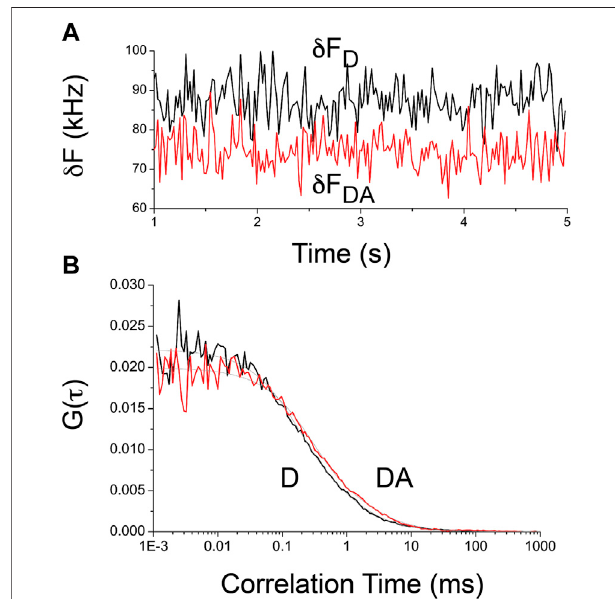
FIGURE 2 | Representative time-dependent fl uorescence fl uctuations and autocorrelation curves of intact and enzymatically-cleaved crTC2.1 construct (A) Representative fl uorescence fl uctuation traces of cleaved (black trace) and intact (red trace) of crTC2.1 indicate difference in the average number of fl uorescence photons detected during their translational diffusion through the open observation volume (B) The corresponding autocorrelation curves of cleaved (black curve) and intact (red curve) of crTC2.1. Under 405 nm excitation (7 μ W), the fi tting parameters of these representative autocorrelation curves are as following: the translational diffusion times are 0.57 ms (cleaved) and 1.0 ms (intact) with a fast photophysical process with time scales of 180 μ s (cleaved, 41%) and 299 μ s (intact, 47%). The corresponding number of molecules residing in the observation volume here are 45 (cleaved) and 50 (intact).